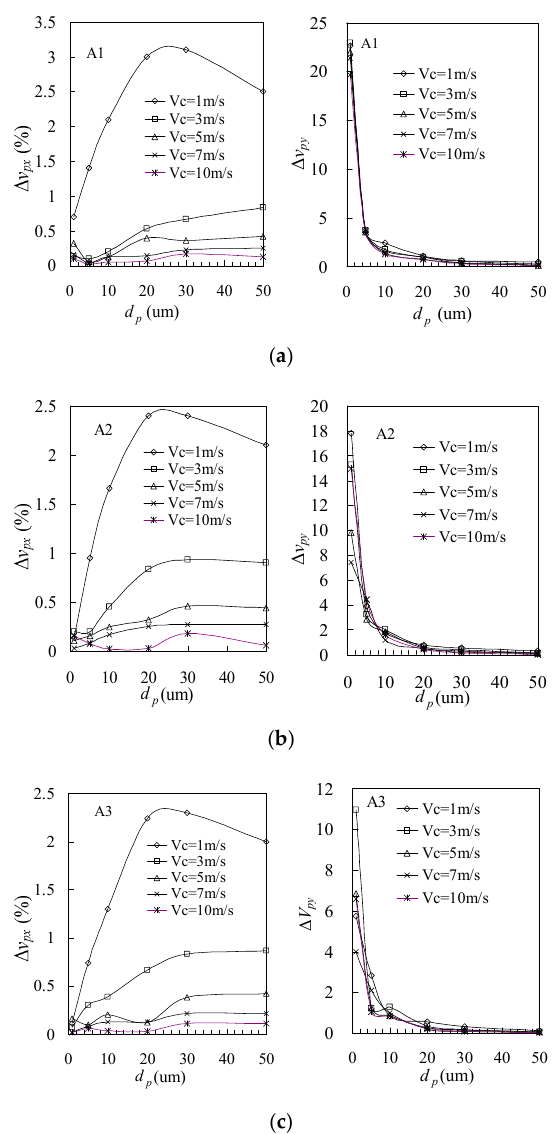
Figure 5. The variation of particle velocity affected by electric force. ( a ) Position A 1 ; ( b ) Position A 2 ; ( c ) Position A 3 .